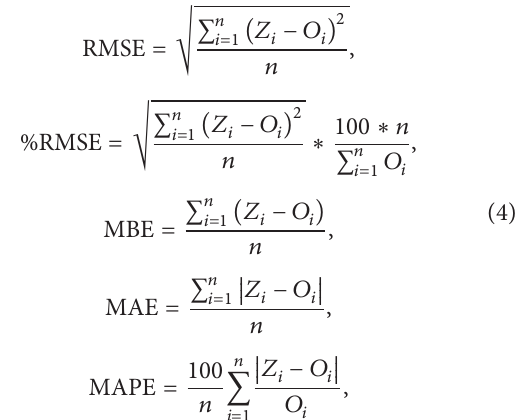
error (RMSE), percentage root mean square error (%RMSE), mean bias error (MBE), mean absolute error (MAE),